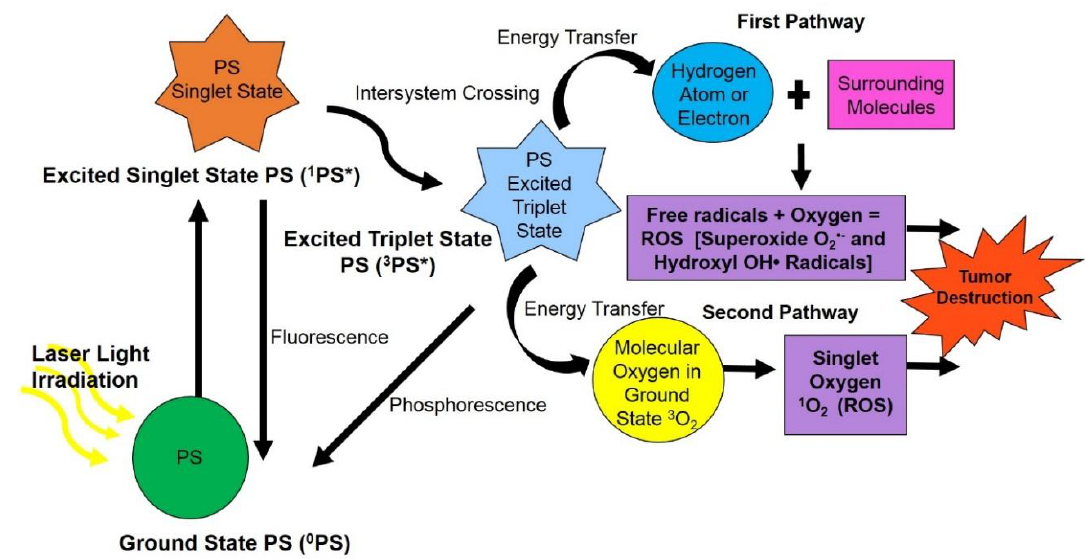
Figure 2. Photodynamic therapy photochemical and photophysical mechanism of photosensitiser drug activation in tumour cells at a specific wavelength of light leading to transfer of oxygen molecules or other substrates in surrounding areas, generating cytotoxic ROS, which triggers apoptotic or necrotic forms of cell death and so tumour cells are destroyed.